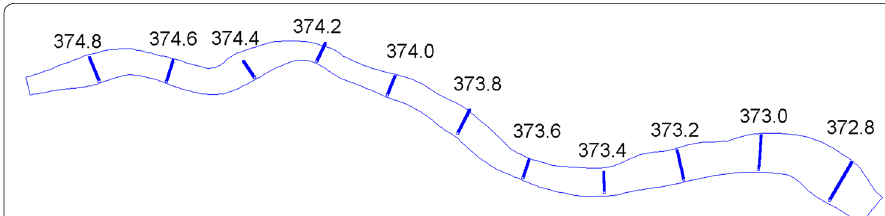
Fig. 10 Plan view of the Bodendorf reservoir. The numbers indicate the cross-sectional profiles where bed level elevations were measured before and after the flushing